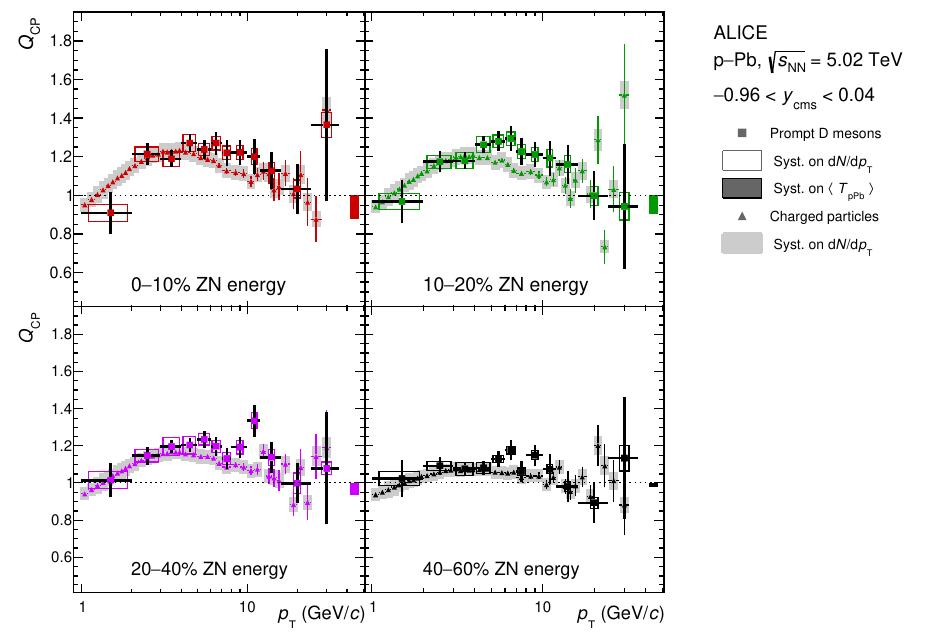
Figure 12 . Average D-meson and charged-particles [69] Q CP using the yields measured in 0{ 10%, 10{20%, 20{40%, and 40{60% as numerators and the yield in 60{100% as the denominator. The vertical bars and the empty boxes represent the statistical and systematic uncertainties. The colour-(cid:12)lled boxes at Q CP = 1 represent the normalisation uncertainties on the h T pPb i